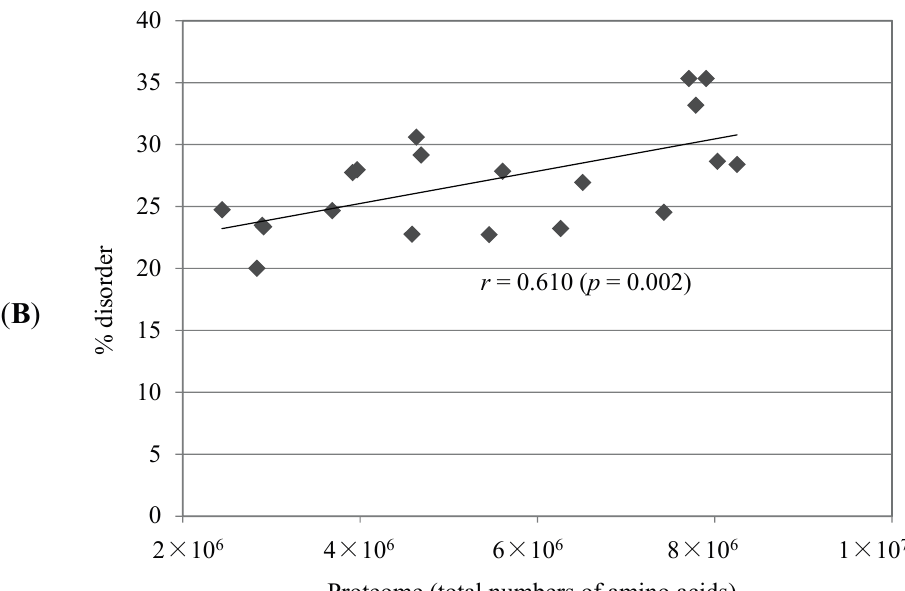
Figure 1. Evaluation of global protein disorder in algae proteomes. ( A ) Predicted disordered protein content in the studied algae proteomes computed with DISOPRED; ( B ) Results of a pairwise correlation analysis between the disorder content and the total number of amino acids in a